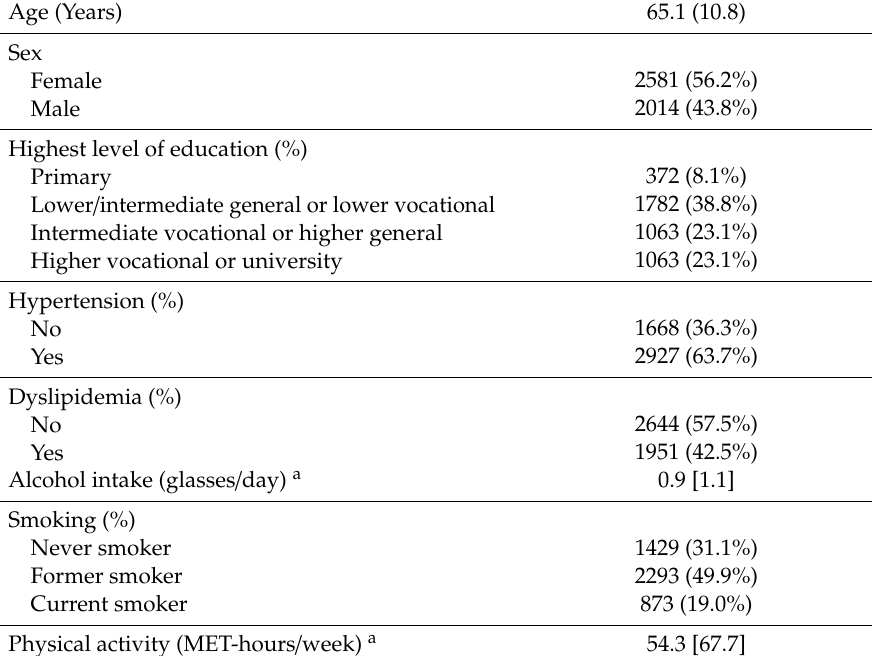
Table 1. Baseline characteristics of the total study population ( n =